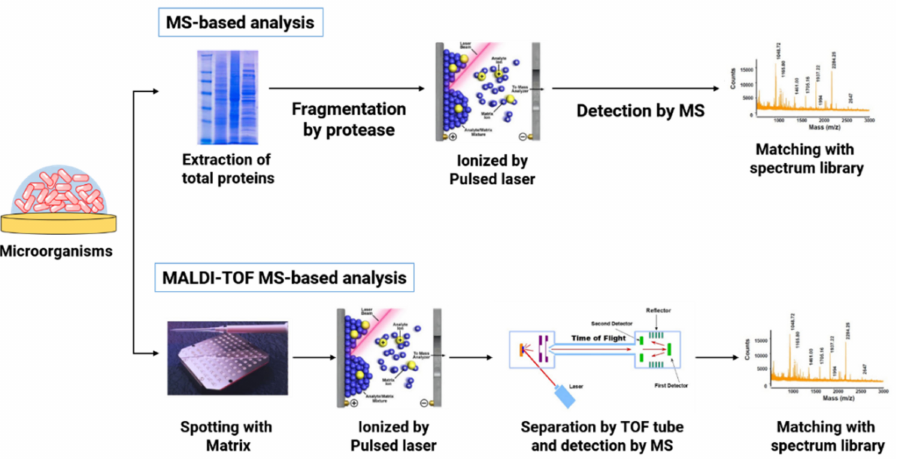
Figure 1. Schematic representation of MS and MALDI TOF MS operation for microorganism